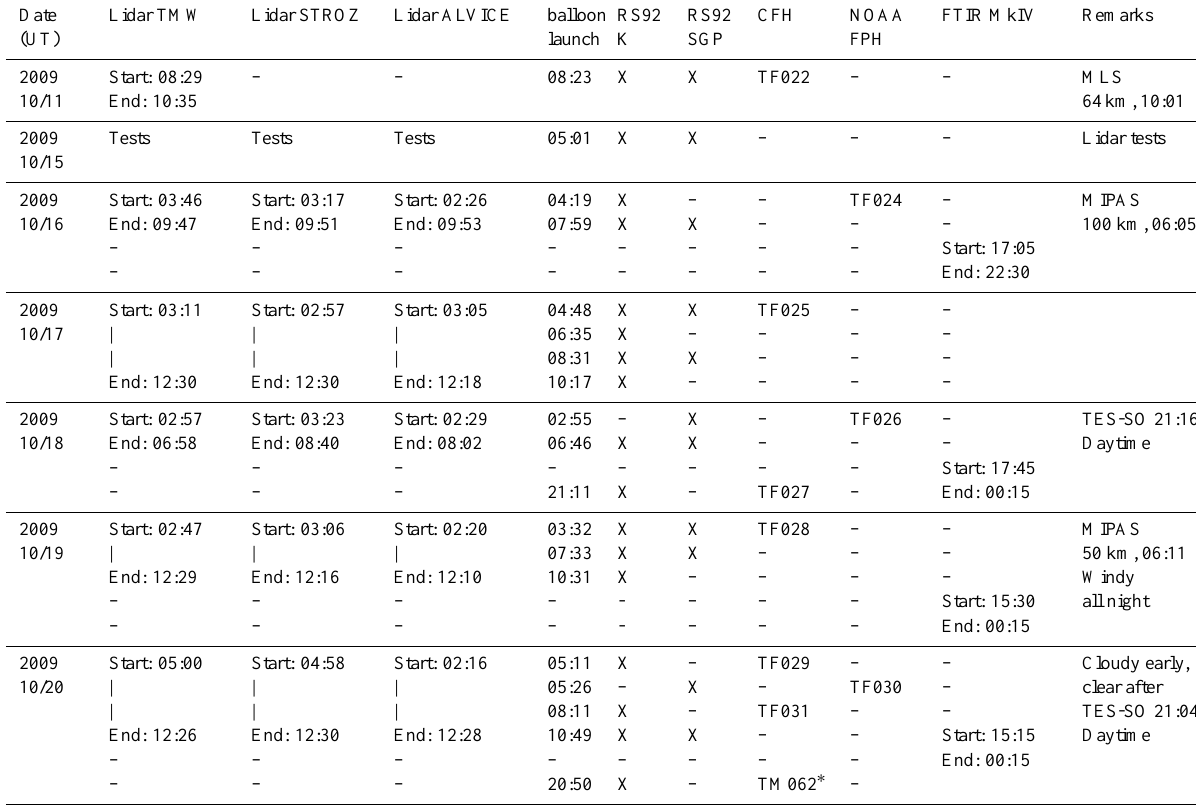
Table 2a. Summary of MOHAVE-2009 operations (11–20